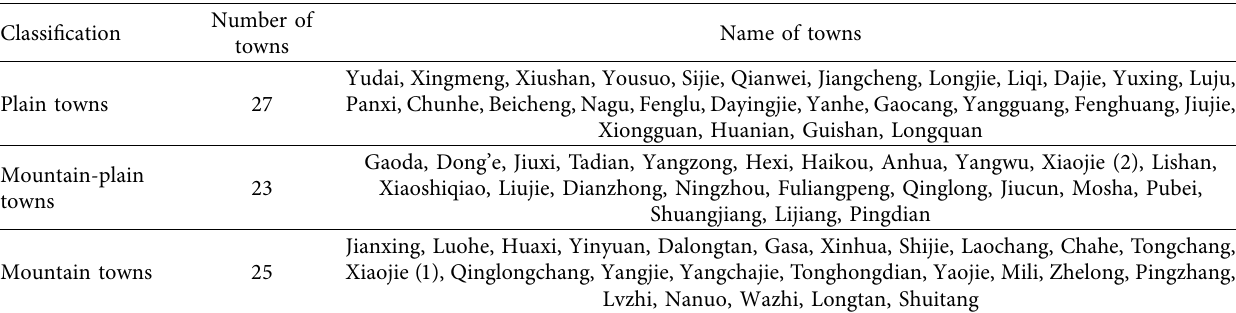
Figure 5: (a) Land types, (b) cultivated land types, (c) construction land types, and (d) town types in Yuxi city. Table 6: Classification scheme of plain areas and mountainous